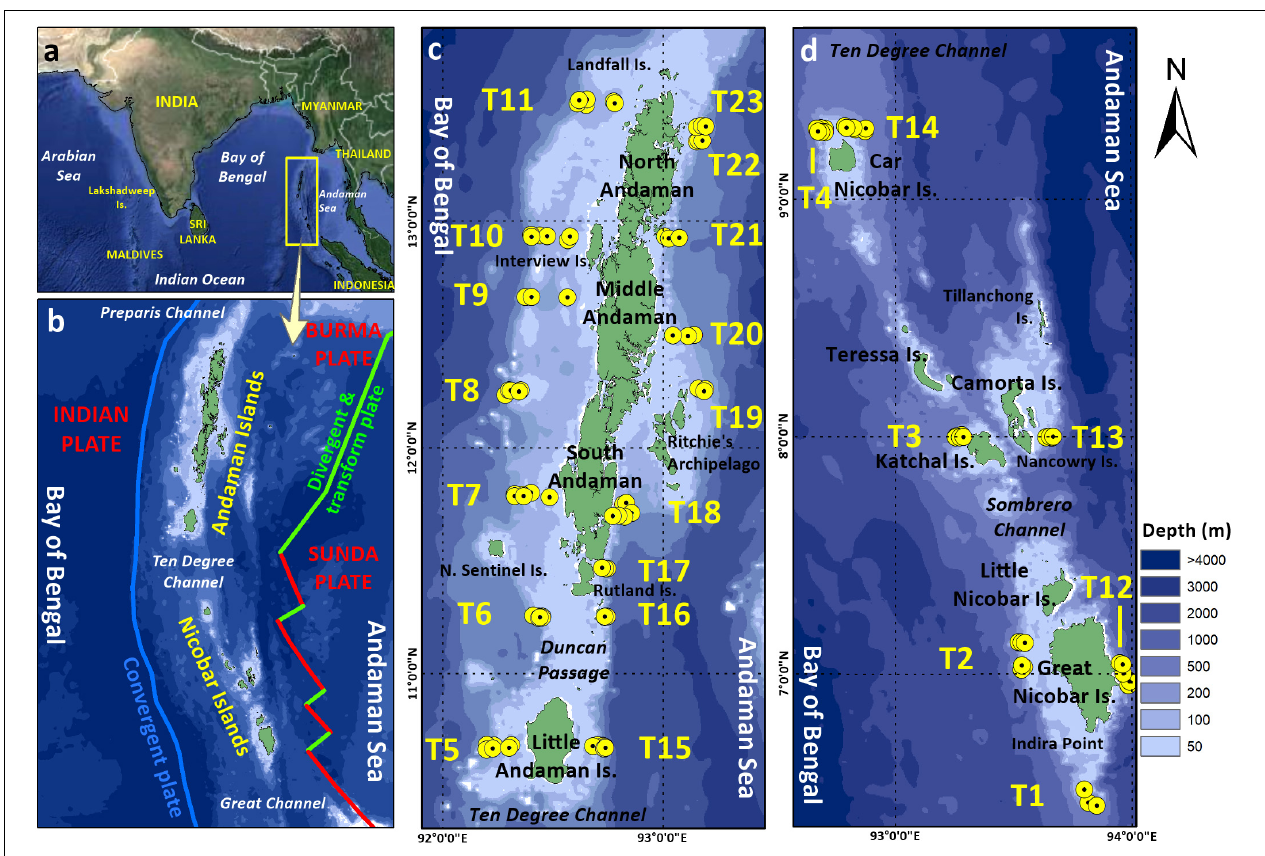
FIGURE 1 | Map showing (a) location of the Andaman and Nicobar Islands in the northern Indian Ocean, (b) entire Andaman and Nicobar Archipelago with limits of tectonic plates, (c) Andaman Islands, and (d) Nicobar Islands. Yellow ( • ) represents sampling sites.